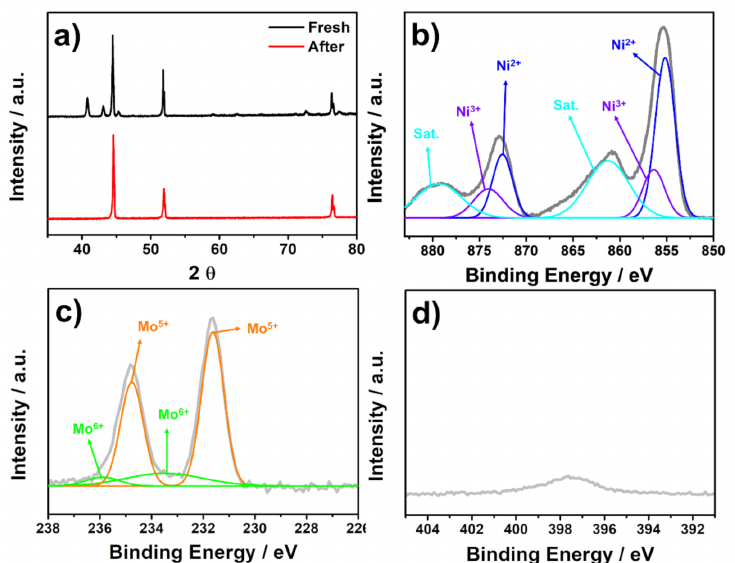
Figure 4. ( a ) XRD patterns of Ni 2 Mo 3 N/NF (fresh and after the durability test). XPS spectra of Ni 2 Mo 3 N/NF after the durability test. ( b ) Ni 2p, ( c ) Mo 3d, and ( d ) N 1s. SEM and TEM measurements were conducted to inspect the morphologies of the Ni 2 Mo 3 N/NF after the durability tests (Figure 5). The SEM image in Figure 5a shows that Ni 2 Mo 3 N remains on the Ni foam similar to fresh Ni 2 Mo 3 N/NF. SEM-EDS